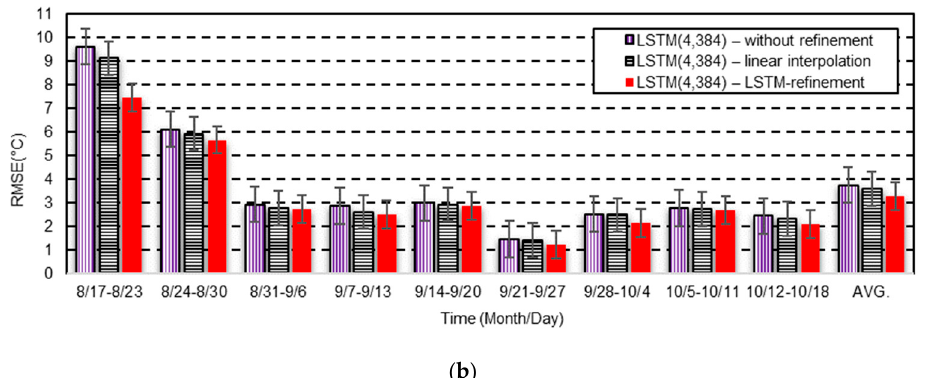
Figure 9. Weekly RMSE and MBE of the LSTM-based models with different refinement methods for two months from August to October in Seoul, Korea for ( a ) 7 day and ( b ) 14 day temperature prediction.